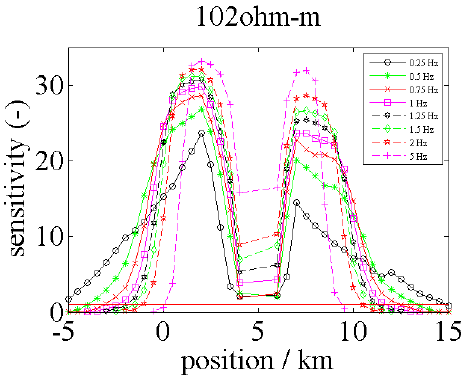
Figure 3. The sensitivity to target model at the receiver’s location.